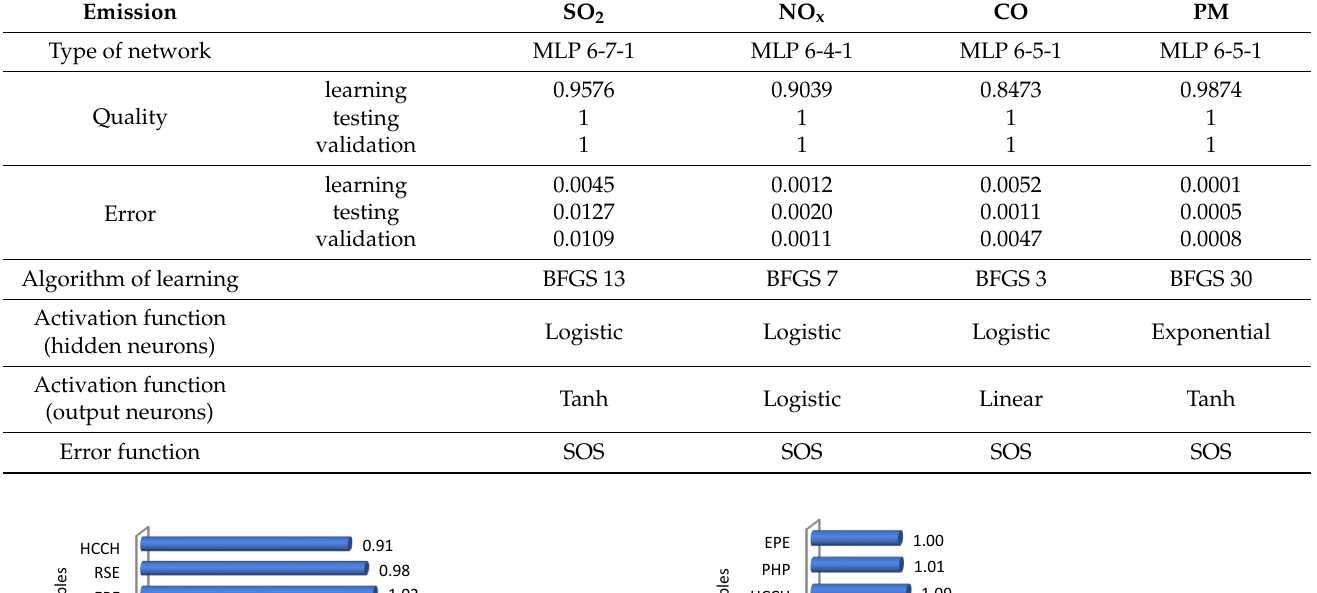
Table 2. Summary of active MLP networks for emissions.